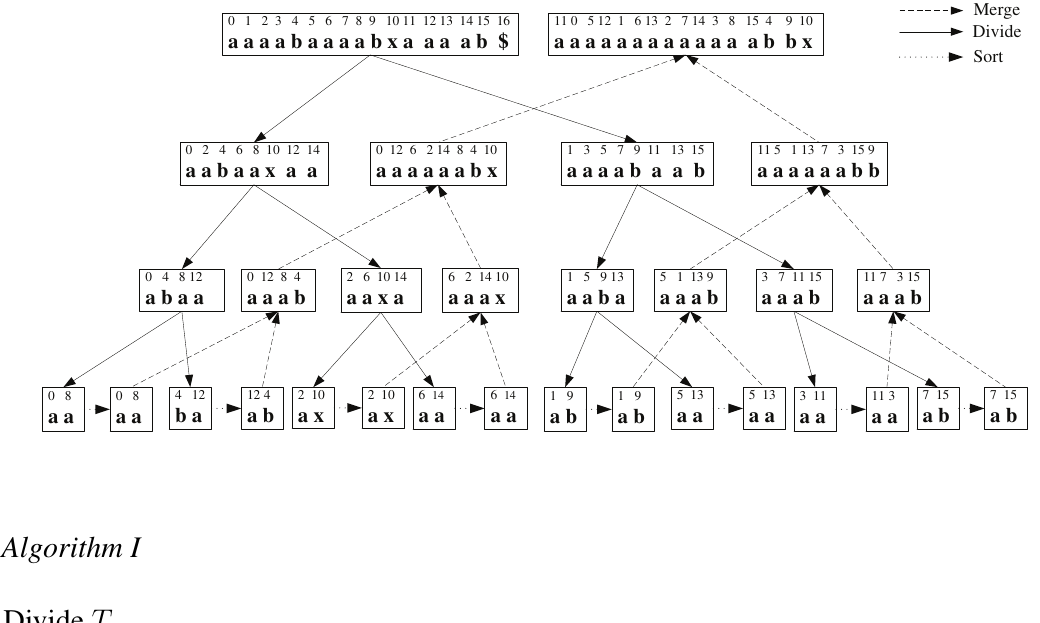
Figure 1. Basic working of the proposed algorithm using an example. The original sequence is indicated at the top left. The sorted sequence and the suffix array are indicated in the top right